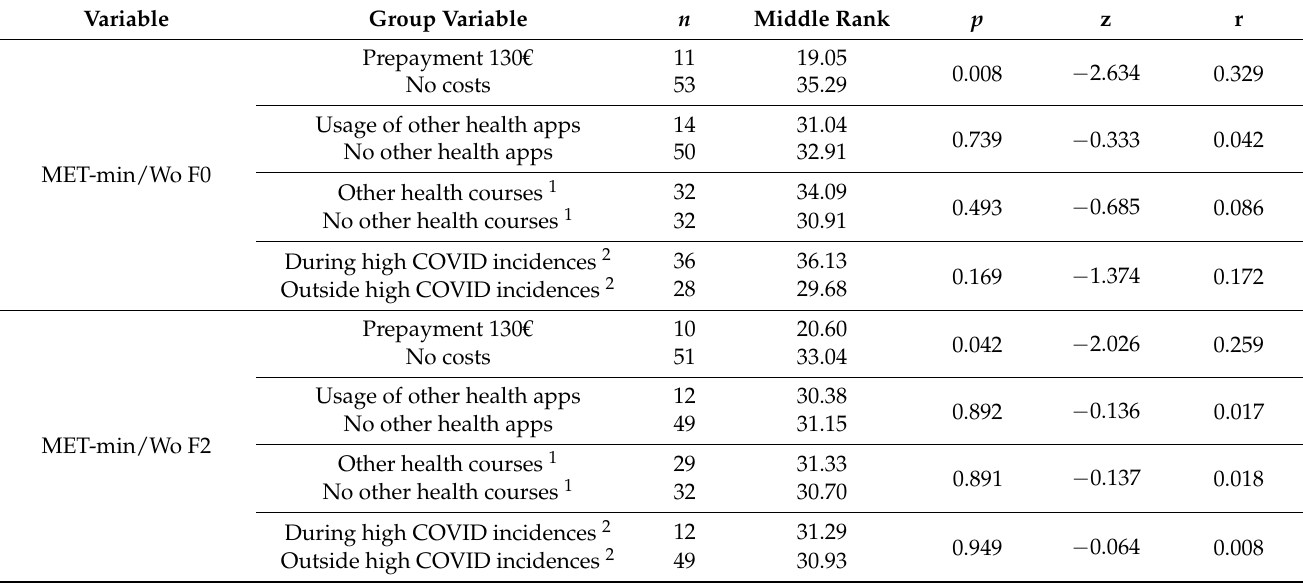
Table A10. Mann-Whiney-U test: Influence of different factors on the effect of the app on the physical activity at the different measurement